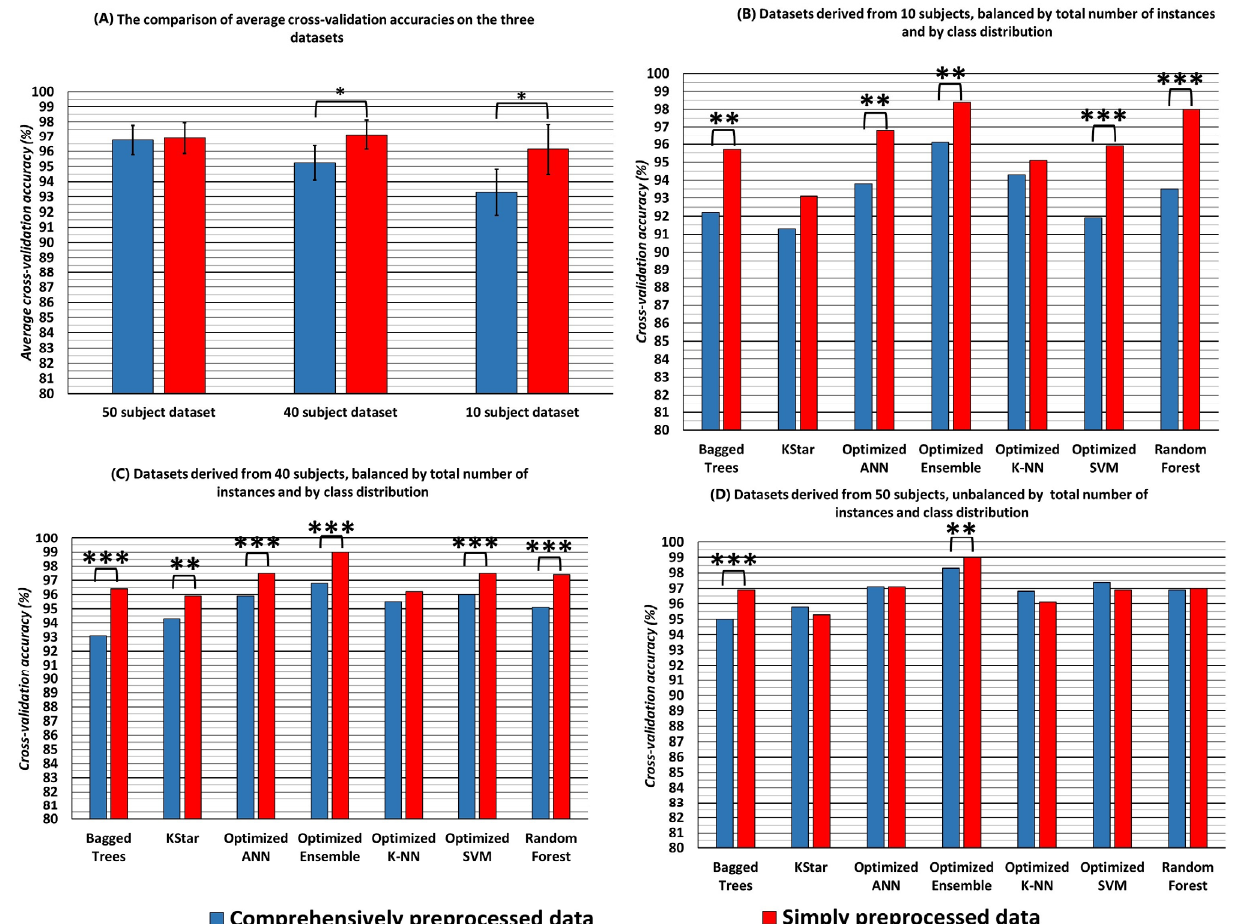
Figure 2. The average 10-fold cross-validation accuracies of the seven classifiers that obtained higher than 95% accuracy in 10-fold cross-validation. The accuracies were obtained by training the classifiers on the datasets and then averaged over all the used classifiers. Blue columns represent accuracies for the comprehensively preprocessed data, while red columns represent the accuracies for the simply preprocessed data. The * symbol denotes statistically significant difference in the average accuracy, at the level of p < 0.05, while the ** and *** symbols denote significance at the <0.01 and <0.001 level. The error bars in ( A ) represent 95% confidence intervals of the mean.